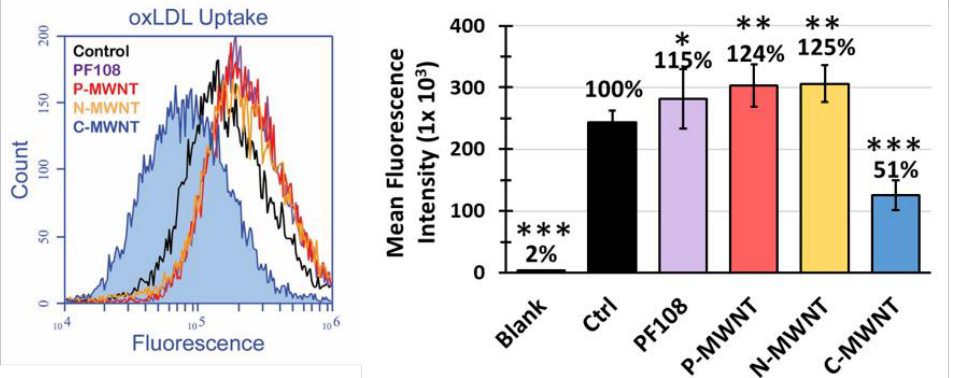
Figure 8. Reduced fluorescent oxLDL uptake by RAW 264.7 cells pre-treated with C-MWNTs, but not P- or N-MWNTs. RAW 264.7 cells were incubated in media containing either 0.1 mM PF108 alone or 100 µ g / mL of P-, N-, or C-MWNTs at 37 ◦ C for 24 h. Untreated control cells were incubated in regular culture medium in the absence of PF108 surfactant or MWNTs. After the pre-treatments, cells were washed and serum starved for 4 h in serum-free medium before incubation in fresh serum-free medium containing Alexa Fluor ® 488-conjugated oxLDL (1:20 dilution for FM and 1:40 dilution for FCyt) for 2 h at 37 ◦ C. Cells were washed again, chilled to 4 ◦ C, and prepared for FM or FCyt as described in Methods. ( A ) The timeline schematic outlining the key experimental steps. ( B ) Representative epi-fluorescence images of the control and treated cells. Blue fluorescence is emitted from Hoechst 33342 stained nuclei and green fluorescence is from internalized Alexa Fluor ® 488-conjugated oxLDL. ( C ) Representative fluorescence histograms of control cells (black), cells pre-treated with 0.1 mM PF108 (purple), 100 µ g / mL of P-MWNTs (red), N-MWNTs (yellow), or C-MWNTs (blue) are plotted on the left. The internalized oxLDL is represented as the mean fluorescence intensity of a total of 10,000 cells analyzed per sample and plotted as a bar graph on the right. Data are the mean ± SD of triplicate samples in ≥ 4 independent experiments. Percent values shown above the bars indicate mean fluorescence intensity relative to untreated control cells where the level of oxLDL was set to 100%. * is for p < 5.0 × 10 − 2 , ** is for p < 5.0 × 10 − 5 , and *** is for p < 5.0 × 10 − 10 against control.